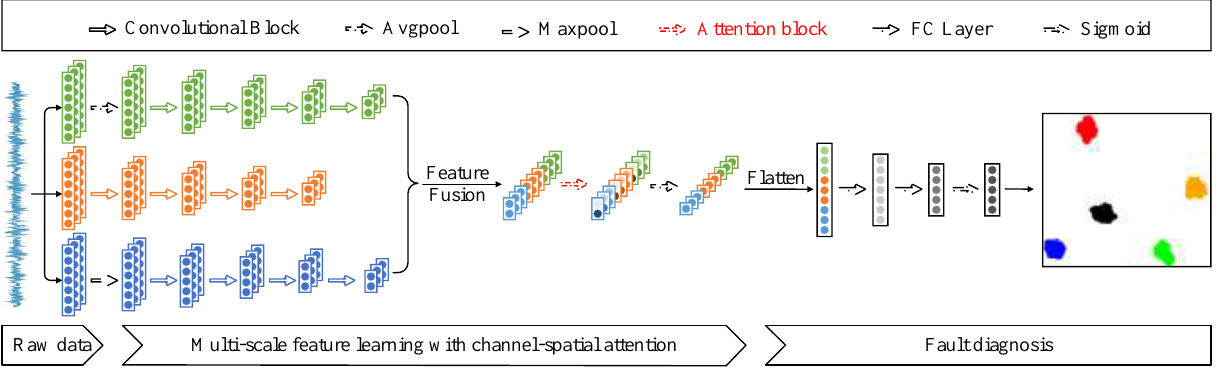
Figure 6. CSAM-MSCNN architecture diagram. The feature extraction layer performed feature extraction on the input sample X using three different scales. The first scale obtained the scale information of the vibration signal by averaging pooling and subsequently mined its deeper fault information using four convolution blocks. Each convolutional block contained a one-dimensional convolu- tional layer, a batch normalization layer, an activation function ReLU, and a highest pool- ing layer. The second scale directly used four convolutional blocks for feature extraction of the original scale signal. The difference is that the first layer convolution kernel used a wide convolution kernel with a sizeable sensory field to obtain global information and shallow features. Then three convolution blocks were used to mine deep features. Unlike the first scale, the third scale used maximum pooling to obtain the scale information of the vibration signal, followed by the same four convolutional blocks to learn the fault infor- mation in the scale signal. The extracted features at three scales are 1 f , 2 f ,